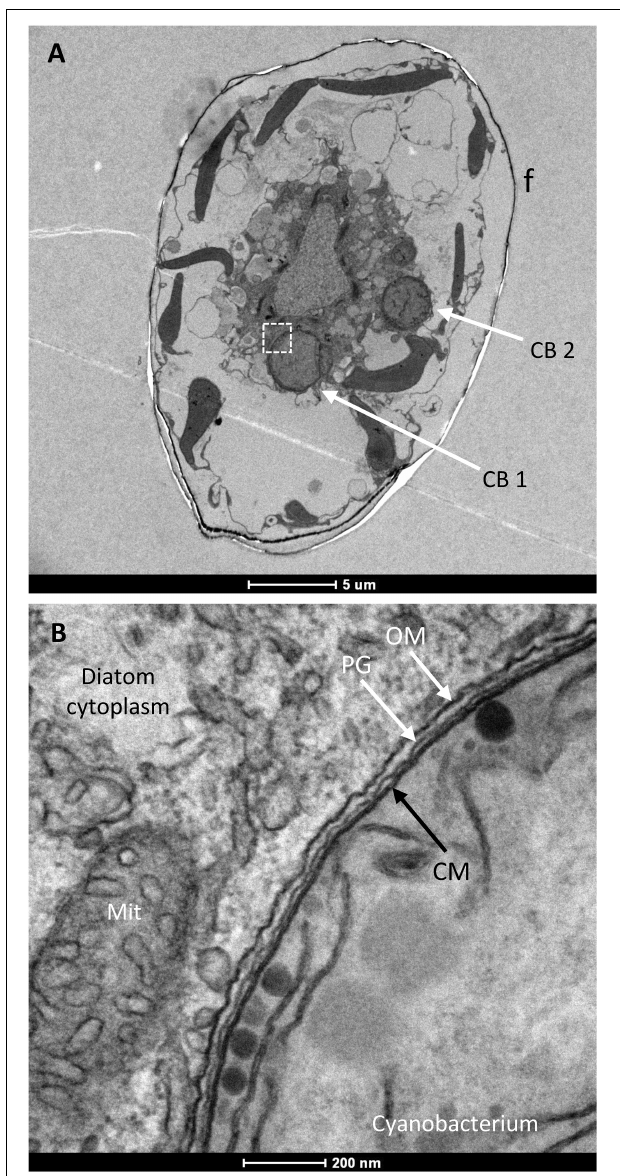
FIGURE 3 | Transmission electron micrograph of a H. hauckii cell. (A) Transverse section of the diatom containing two cyanobacterial cells (CB) also mainly in transverse section; f, diatom frustule. (B) Magnified view of the diatom cytoplasm and part of the cyanobacterium indicated by the dotted square in panel (A) . Note components of the cyanobacterial cell envelope: CM, cytoplasmic membrane; PG, peptidoglycan layer; OM, outer membrane. Note also the mitochondrion (Mit) close to the cyanobacterial